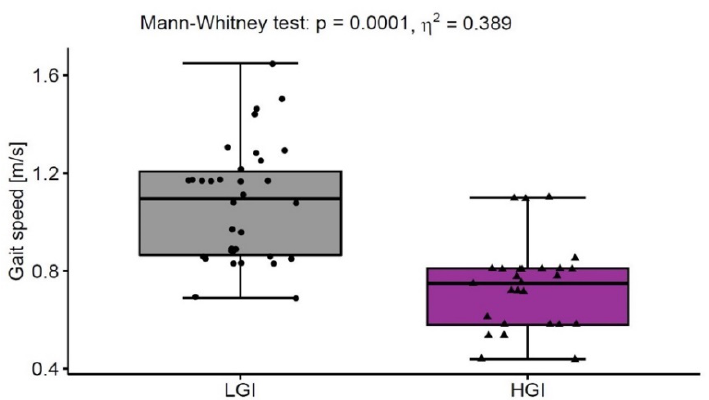
Figure 2. The gait speed in low-grade inflammation group (LGI, n = 33) with normal ranges of CRP (<3 mg/L) and in high-grade inflammation group (HGI, n = 27) with above normal ranges of CRP ( ≥ 3 mg/L).